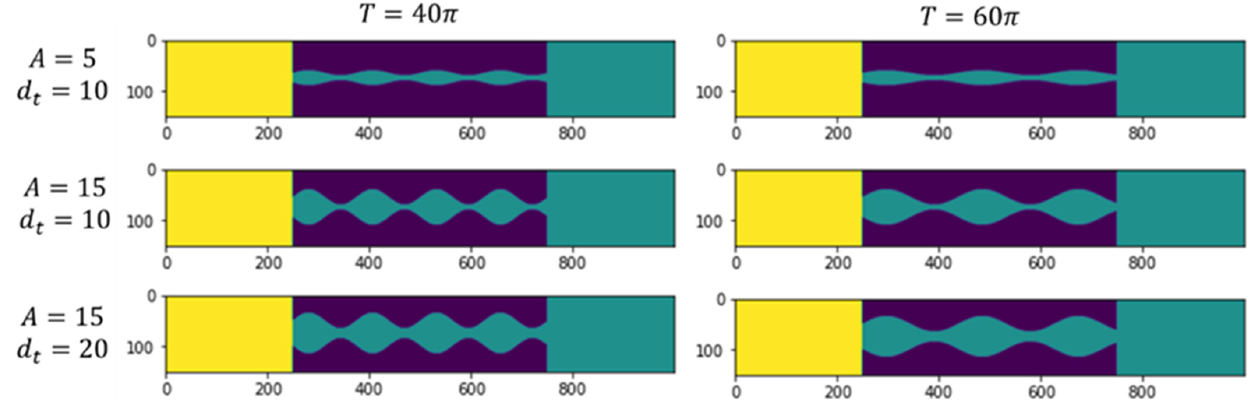
d ). Figure 10. The capillary shapes under different parameters ( A , T , and d t t d ). t